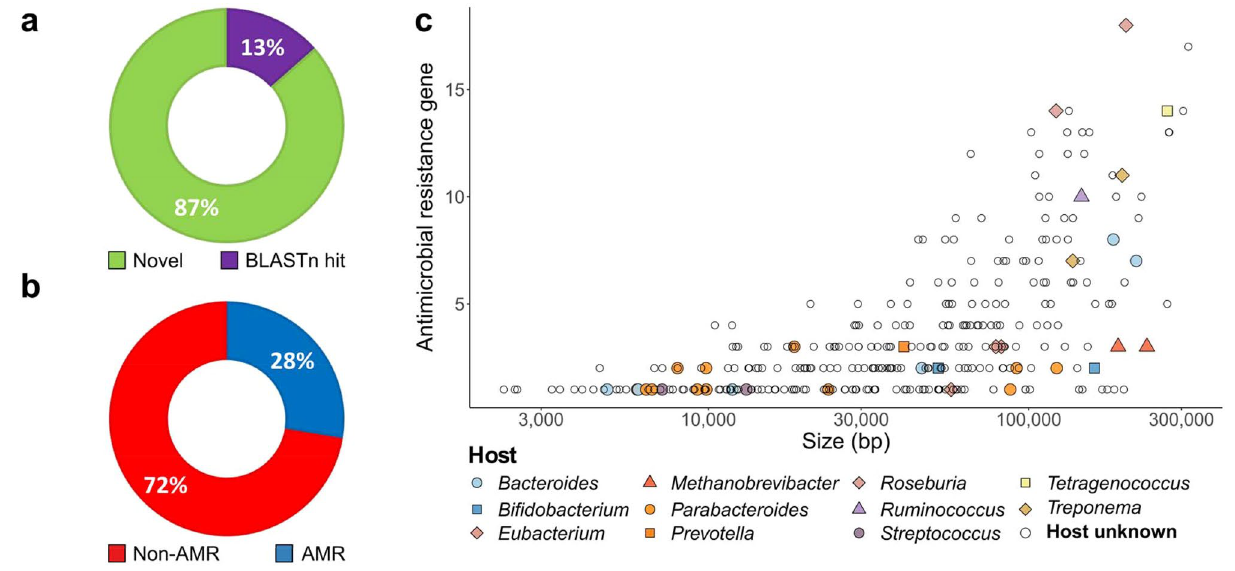
Figure 2. The human plasmidome is an under-explored source of important microbiome functions. The percentage of human microbiome plasmids with ( a ) a nucleotide blast hit against NCBI’s NT database, or ( b ) containing one or more antimicrobial resistance (AMR) genes. ( c ) Plasmid size versus the number of AMR encoding genes, with shape and colour aesthetics highlighting predicted